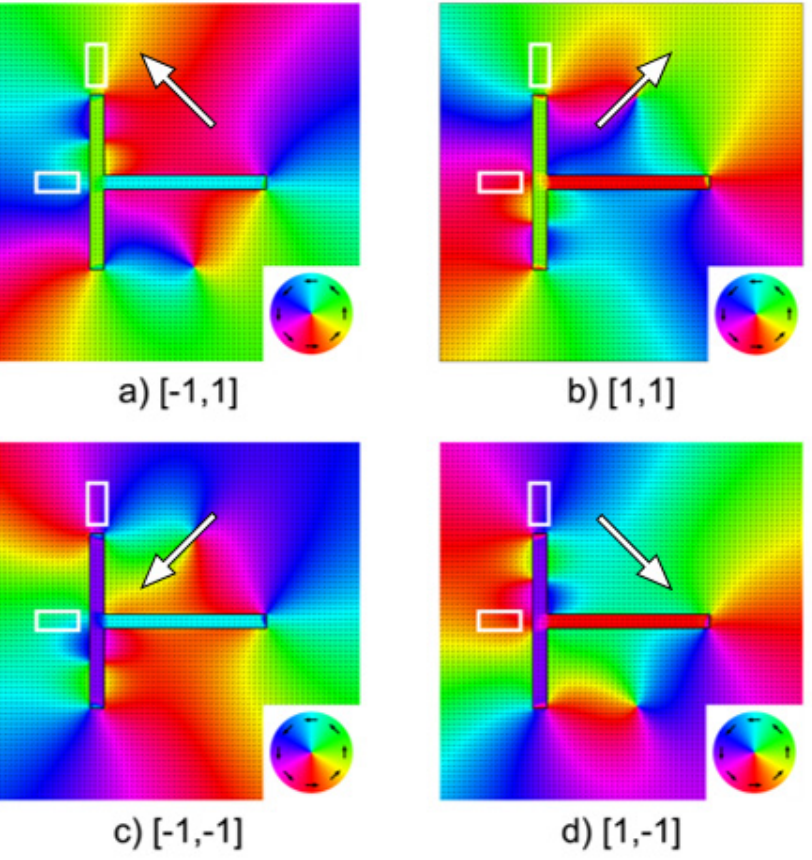
Figure 4. Micromagnetic simulations of the four relaxed stable magnetic states [ m x , m y ] at H = 0 (remanent state) for T-Shapes with L = 5 µ m and the stray-field generated by them: ( a ) [ − 1, 1], ( b ) [1, 1], ( c ) [ − 1, − 1] and ( d ) [1, − 1]. The white arrows indicate the saturating H field direction applied before the structures are relaxed. The circular insets represent the colormap proportional to magnetic flux induction direction on the xy plane, also indicated by the black arrows. The hollow rectangles indicate areas that can be inspected by tunnel magnetoresistance (TMR) heads in order to read the stray fields generated by the recorded magnetic states and recover the information.